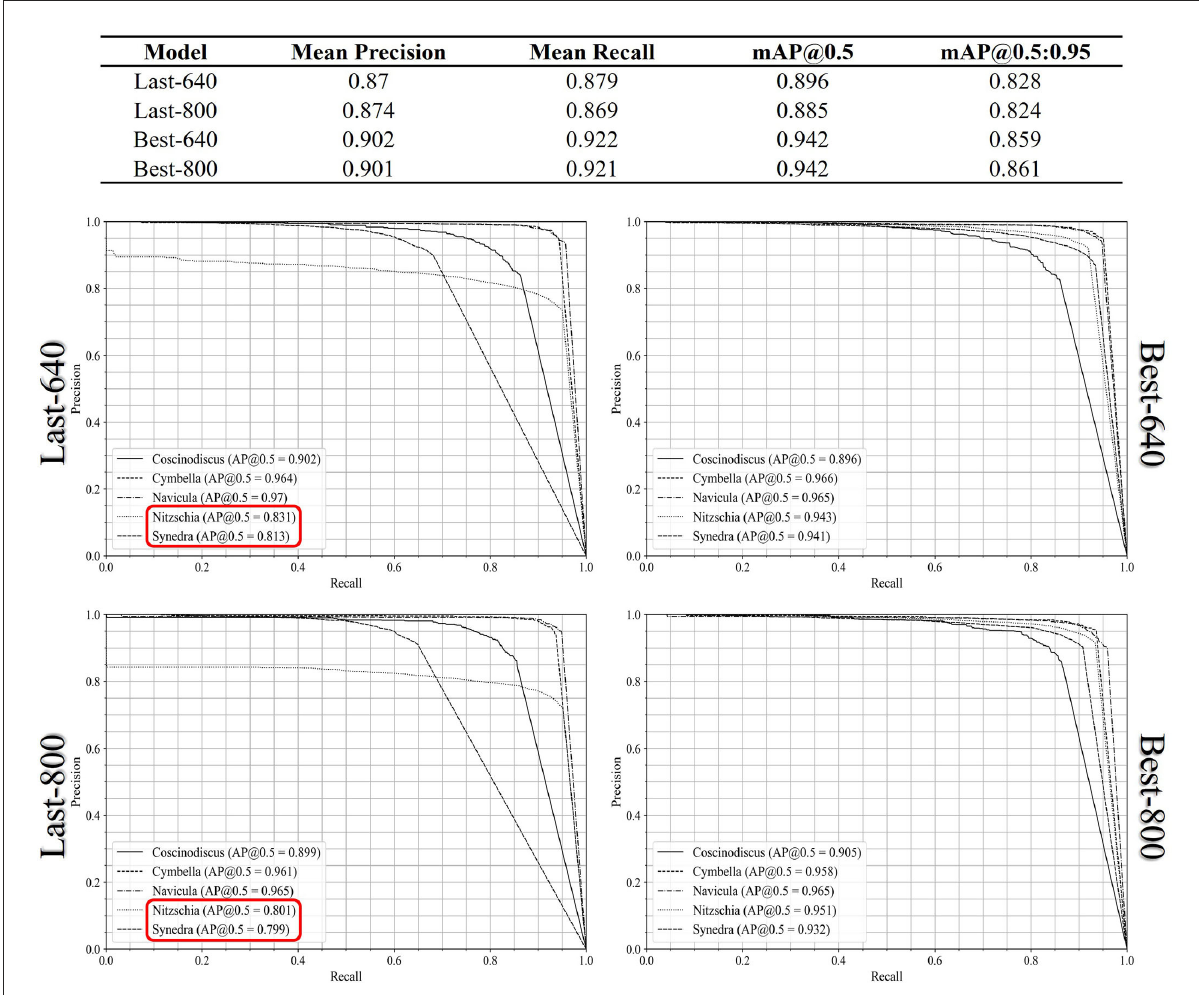
FIGURE6 The precision-recall curves of all the diatom genus achieved by the Last-640, Last-800, Best-640, and Best-800